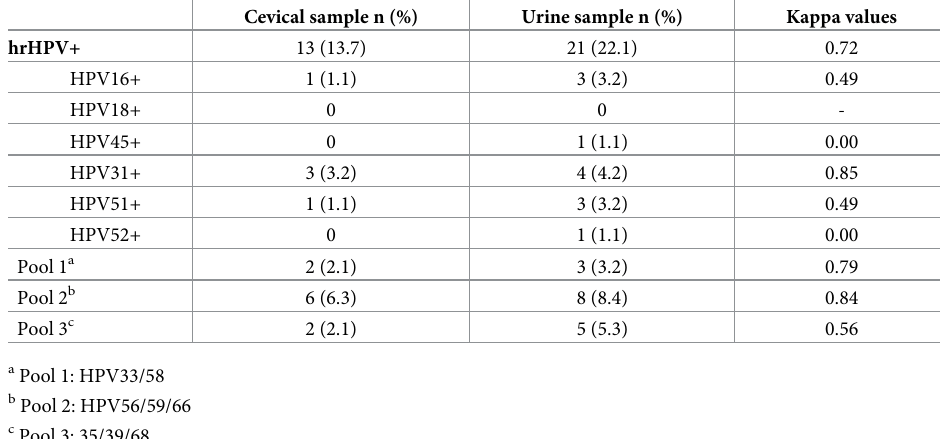
Table 1. Type specific HPV positivity differences between urine and cervical